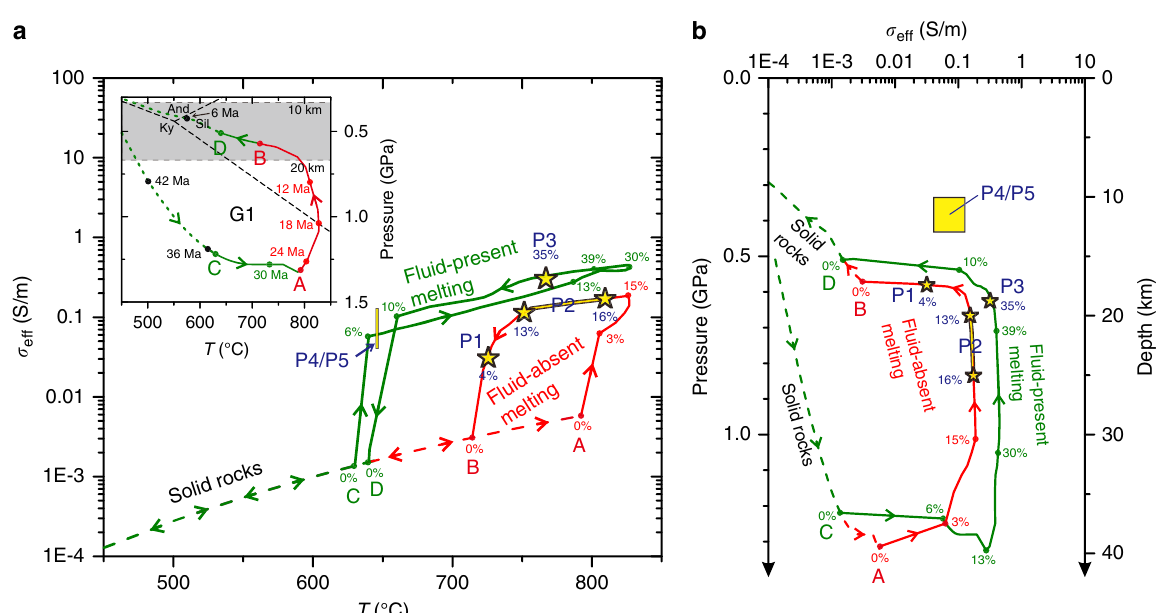
Fig. 5 The electrical conductivity ( σ eff ) – pressure – temperature paths during burial and exhumation of Miocene Himalayan rocks compared with the conductivity of present-day Himalayan crust derived from MT data. a σ eff along the P – T G1 path (inset diagram) as predicted by the “ channel- fl ow model HT1 ” 18 and metamorphic petrology 31 ; the numbers in Ma on G1 path indicate the particle ’ s ages to the present. b Electrical conductivity vs. pressure or depth along the G1 path. The red path represents melt in the absence of excess water (i.e., fl uid-absent melting, approximately dehydration melting) while the green path illustrates melting in the presence of excess water (i.e., fl uid-present melting with excess water content of ca. 1.2%). Dashed curves indicate solid rocks (below solidus), while solid curves (i.e., the lines AB and CD) identify the partially molten domains. Green lines indicate fl uid-present melting (AB), while the red lines refers to fl uid-absent melting (CD). Arrows represent the direction followed during prograde and retrograde metamorphism along the G1 P – T path. The yellow stars and rectangles indicate the conductivity at P1 – P3 and P4/P5 (see Fig.1b, c) from the MT studies 17,34 , respectively, and their sizes represent 30% uncertainty on the MT results. The percentage values on the curves represent the equilibrium melt fractions along G1, and the blue labels de fi ne the melt contents at P1 – P3 (see also Table 3). The high conductivity spots (P1 and P2) are consistent with fl uid-absent melting while P3 may correspond to fl uid-present melting; alternative explanation for P3 are a local melt accumulation process or temperature being 100 °C warmer than those of the G1 P – T path (see text) Table 3 Depth and magmatic conditions of the P1 – P5 anomalies from northwestern Himalaya and southern Tibet Pos Depth